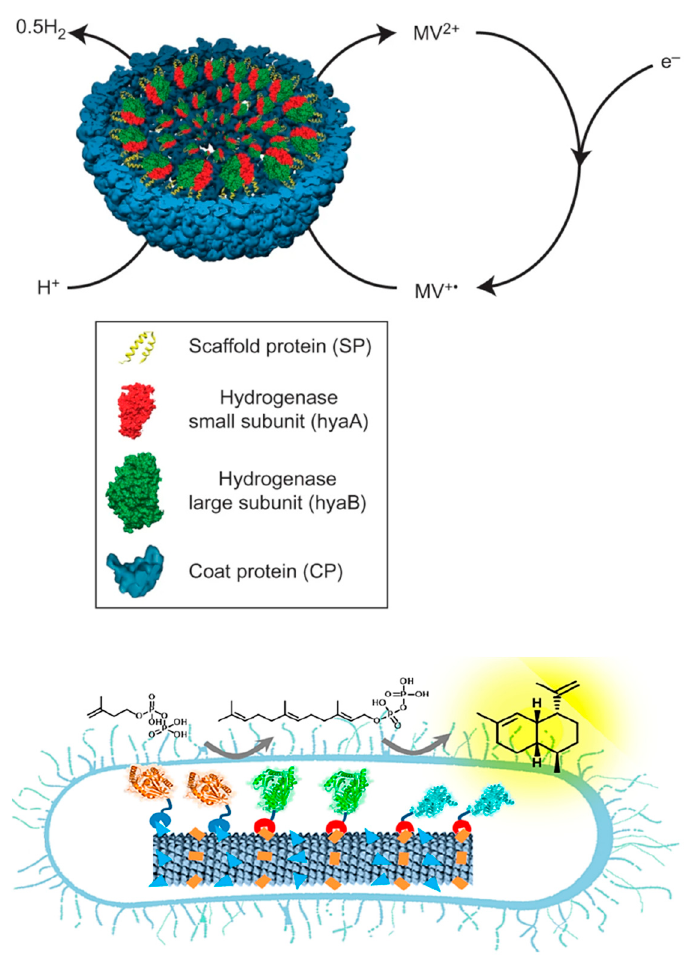
Figure 4. Various applications of VLPs for enzyme scaffolding. ( A ) Repurposing the P22 capsid to house the oxygen-sensitive hydrogenase complex. Reprinted from Douglas and co-workers [63].